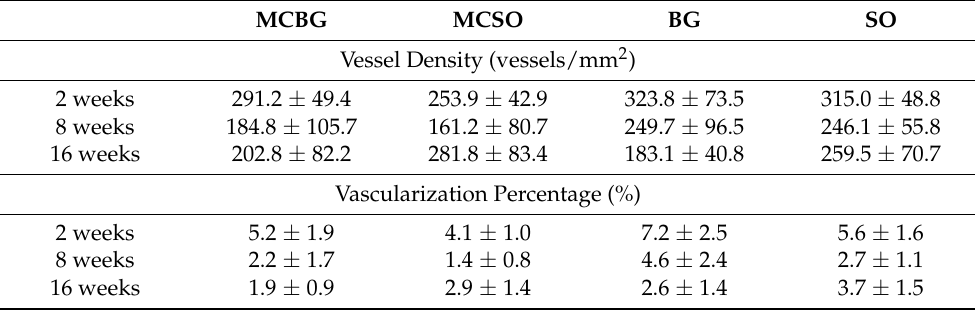
Table 3. Vascularization values (vessel density and vascularization percentage) at 2, 8, and 16 weeks post implantationem. MCBG: membrane compartment above bone graft-filled defects; MCSO: membrane compartment above sham operation; BG: bone graft-filled defect; and SO: sham operation bone defect. MCBG